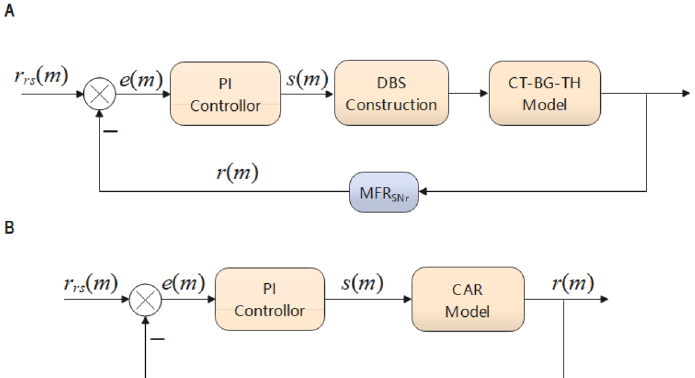
Figure 2. ( A ) The closed loop DBS controller. First, The mean firing rate of SNr is calculated from the absence epilepsy model and used as feedback signals r ( m ) . Then, the difference between the expected mean firing rate r rs ( m ) and r ( m ) is used as input to the PI controller to calculate the frequency or amplitude of DBS stimulate s ( m ) . Finally, the DBS stimulus current input to the absence epilepsy model is constructed. ( B ) Linear system of closed-loop DBS